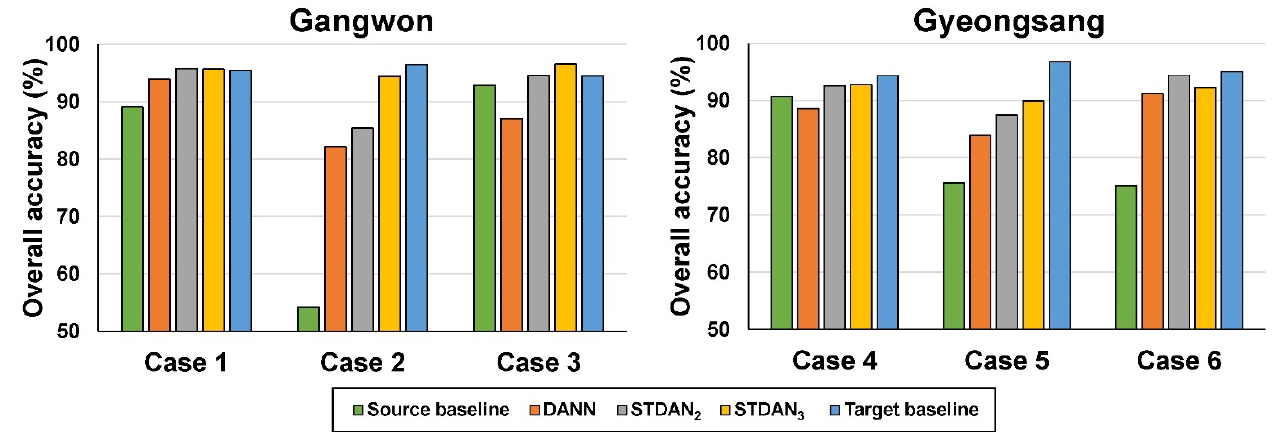
Figure 12. The overall accuracy values of the five classification results for the six domain adapta- tion cases.